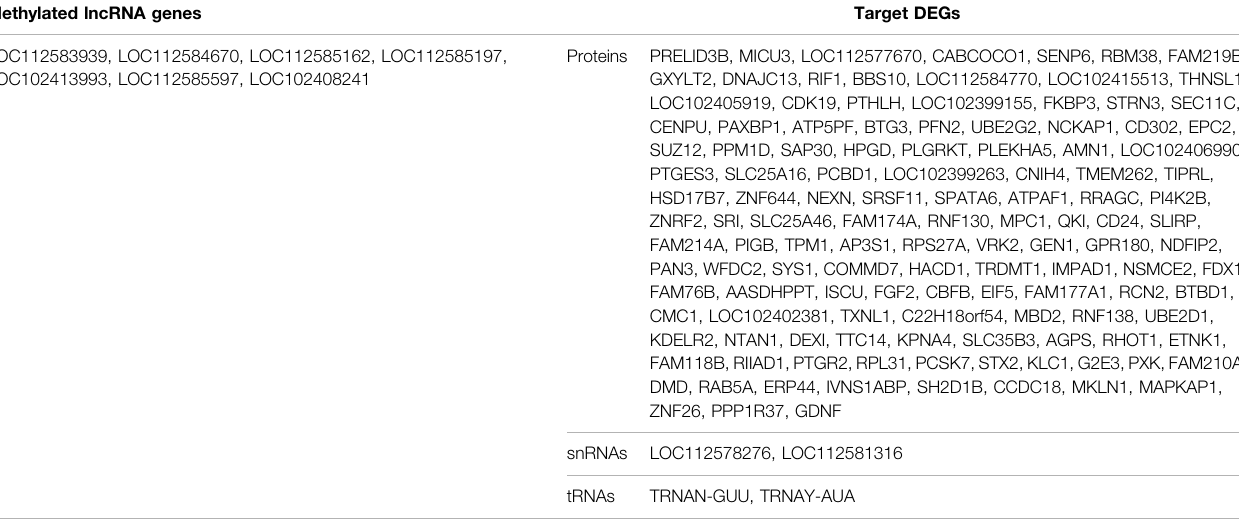
TABLE 6 | Target DEGs of lncRNAs transcribed from methylated genes. Methylated lncRNA